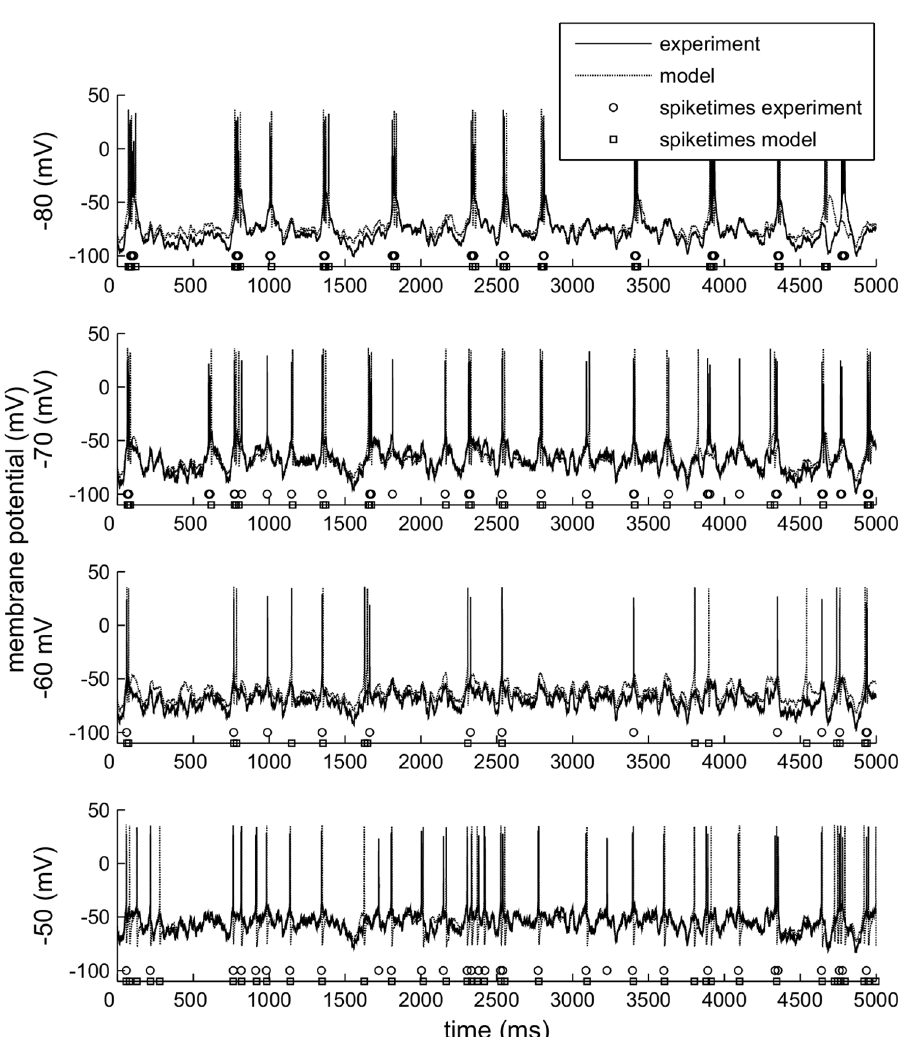
Fig 9. Comparing experimental and model spike trains. The same computer generated frozen noise was injected into the TCR cell (solid line) and in the fine tuned model cell (dotted line). This generated comparable spike trains consisting of isolated spikes and burst in a state dependent way (rows represent the four membrane states. Open circles indicate the timepoints at which the TCR cell fired, while squares mark the moments where the model cell fired, either a spike or a